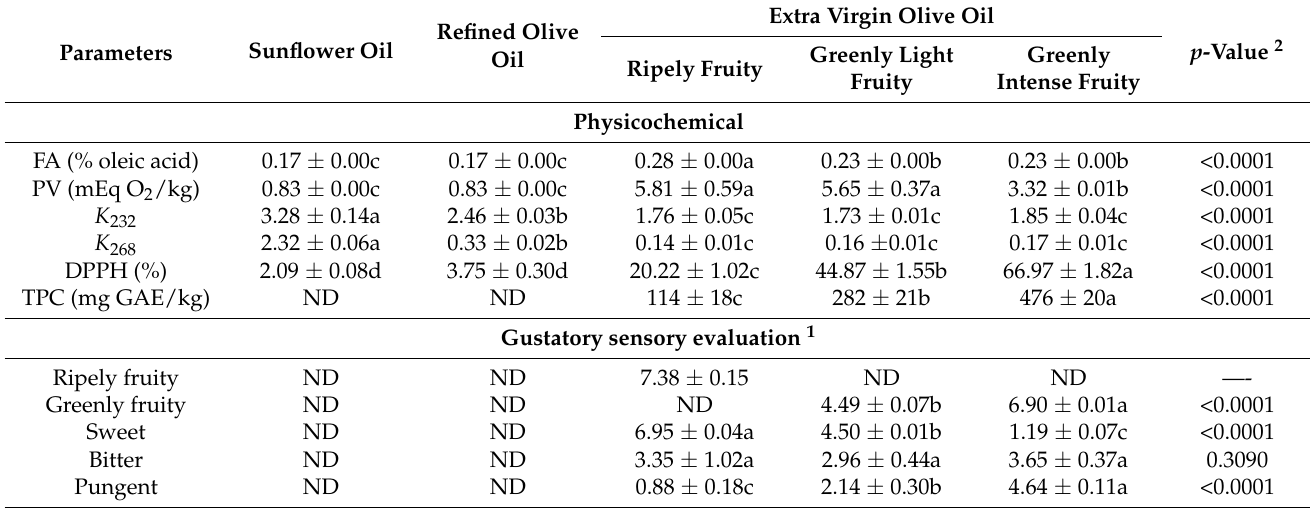
Table 2. Mean values ( ± standard deviation) of physicochemical (free acidity, FA; peroxide values, PV; extinction coefficients at 232 and 268 nm, K 232 and K 268 ; antioxidant activity, DPPH; and, total phenols contents, TPC) and gustatory sensory attributes (ripely fruity, greenly fruity, sweet, bitter and pungent attributes) of oils used as covering media (n = 5 bottles × 3